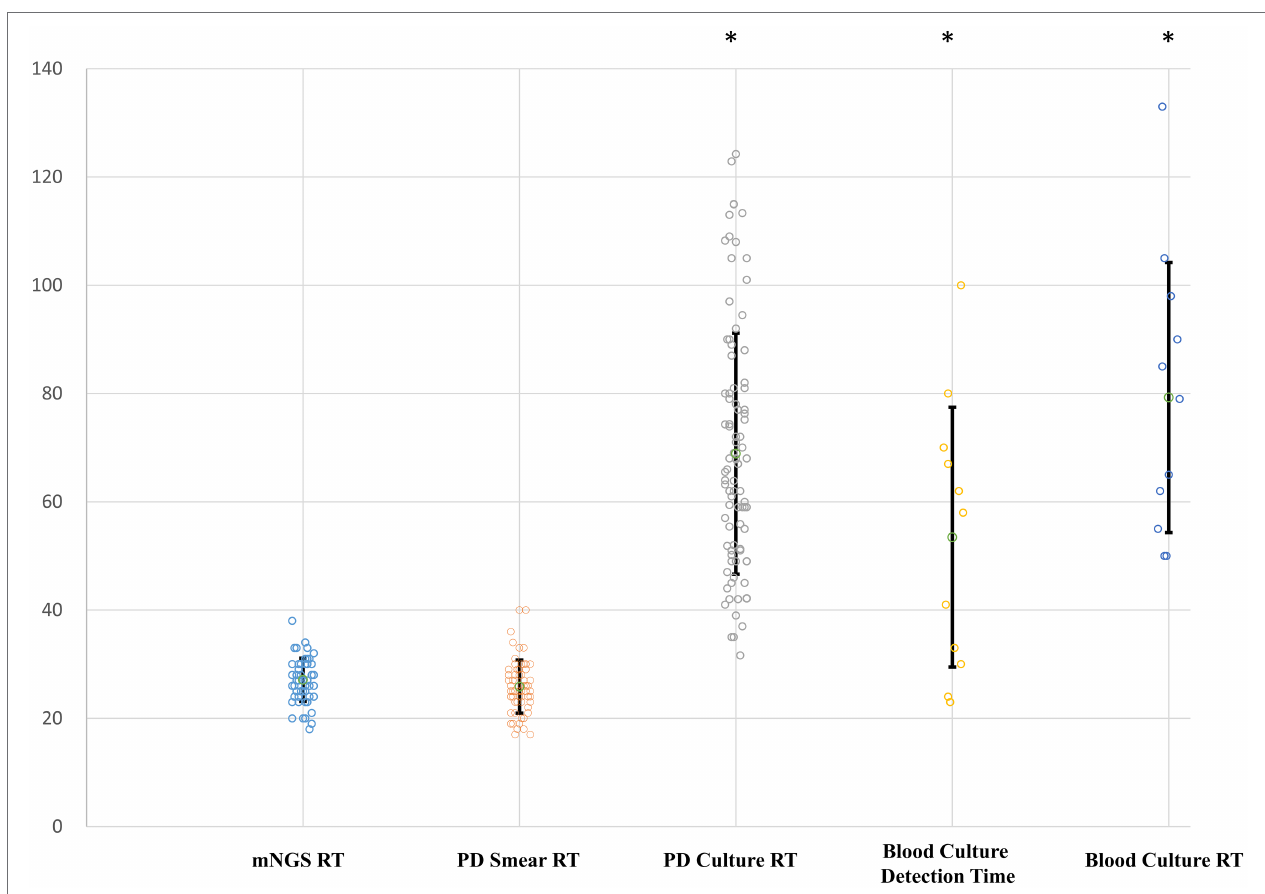
FIGURE 6 | Reporting time (RT) of different pathogen detection methods. Y -axis, hours. RT, reporting time from sampling; PD, peritoneal drainage. Differences between the mNGS group and groups with asterisk were considered statistically significant at p <